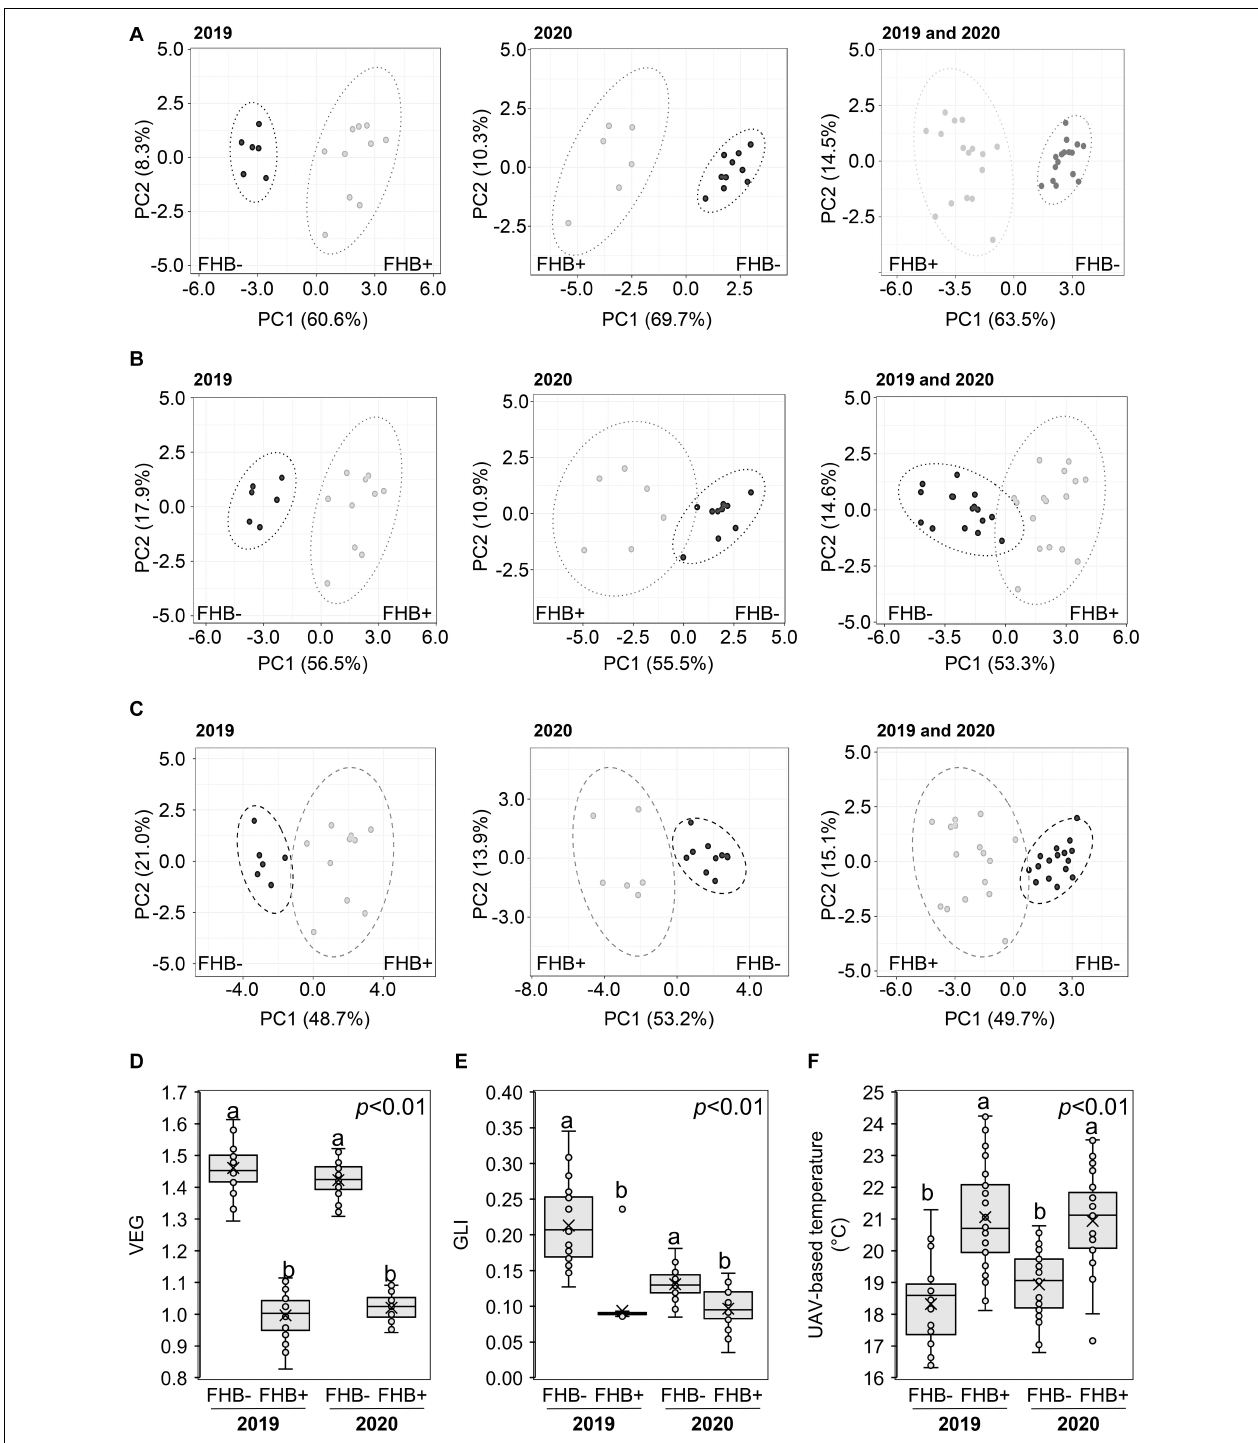
FIGURE 4 | Principal component analysis (PCA) of unmanned aerial vehicle (UAV)-based (A) vegetative index (VEG), (B) green leaf index (GLI), (C) temperature at Zadoks stage (ZS) 65. PCA was performed by using ClustVis Software for p < 0.05 to distinguish between FHB+ and FHB– areas. Box-plot of UAV-based (D) VEG, (E) GLI, and (F) temperature from FHB– and FHB+ areas. Data were recorded during 2019 and 2020. The data represent averages and standard errors for four measurements for each sampling area from 2019 (B,C) and 2020 (D,E) . Different letters refer to the statistical analysis performed using one-way analysis of variance (ANOVA) with the Tukey’s honest significant difference (HSD) post hoc test at 0.95 or 0.99 confidence level and p < 0.05 or p < 0.01. Only the data deriving from 1 year were compared.